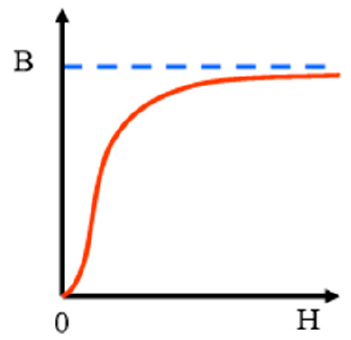
Figure 3. Magnetization characteristics.